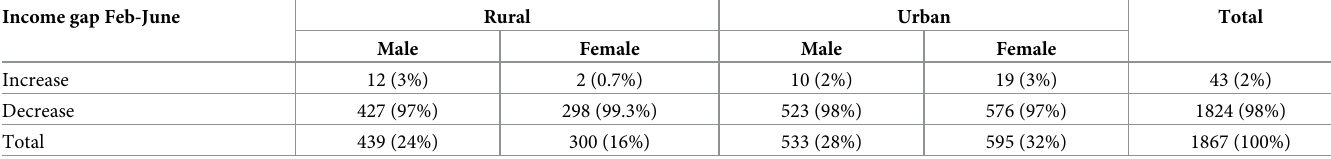
Table 3. Frequency and percentages of the income gap between February and June 2020 according to area and gender.